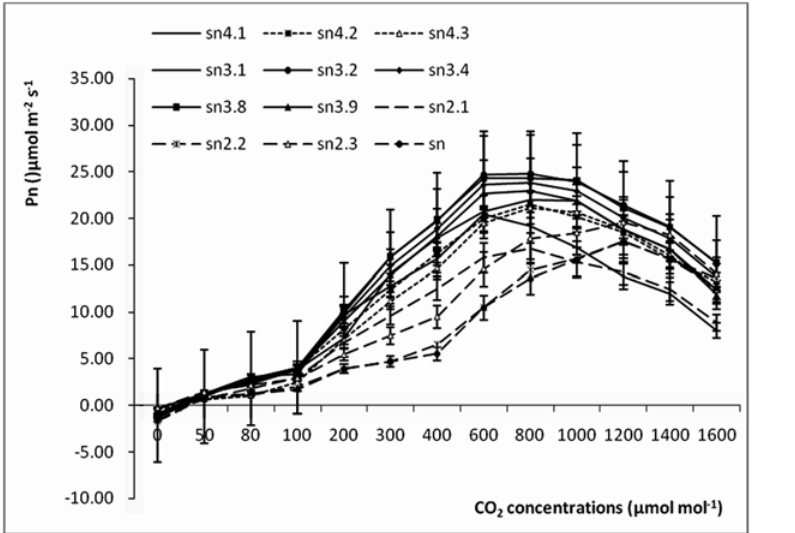
Table 4. The R 2 values of all curve models were higher than 0.9, which indicated that all models were highly efficient. The diploid poplar clones showed higher average CSP and CCP values than the triploids and tetraploids. The average Pn value of the CO diploid clones was lower than in other ploidy level poplar clones. Clone sn3.8 still showed a higher Pn at the CSP, but sn had a lower value.